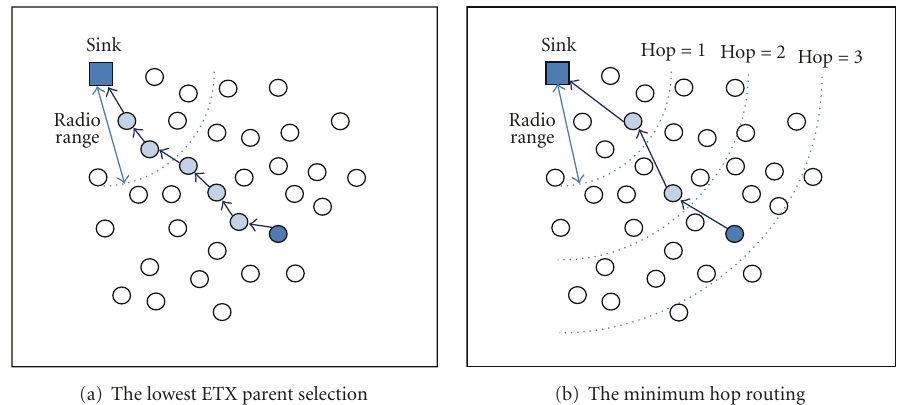
Figure 1: The illustration of the data-gathering tree with the lowest ETX parent selection and the minimum hop routing